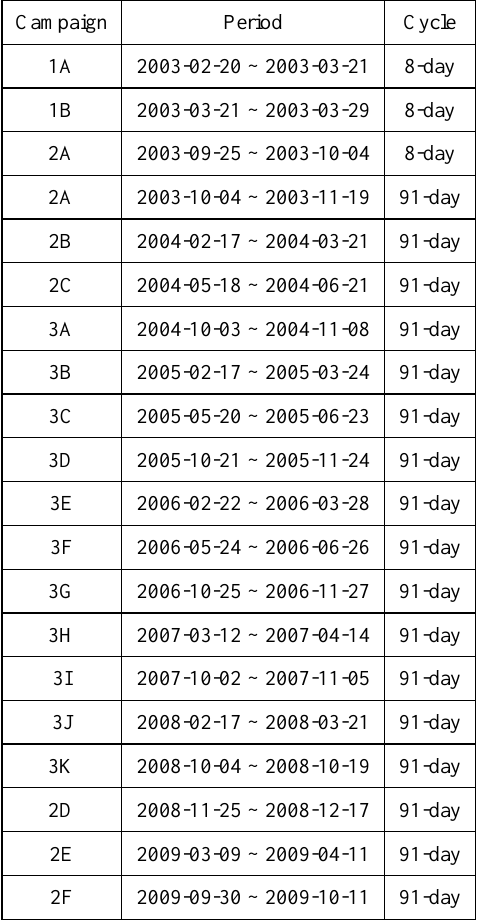
Table 1. Campaigns and corresponding period of